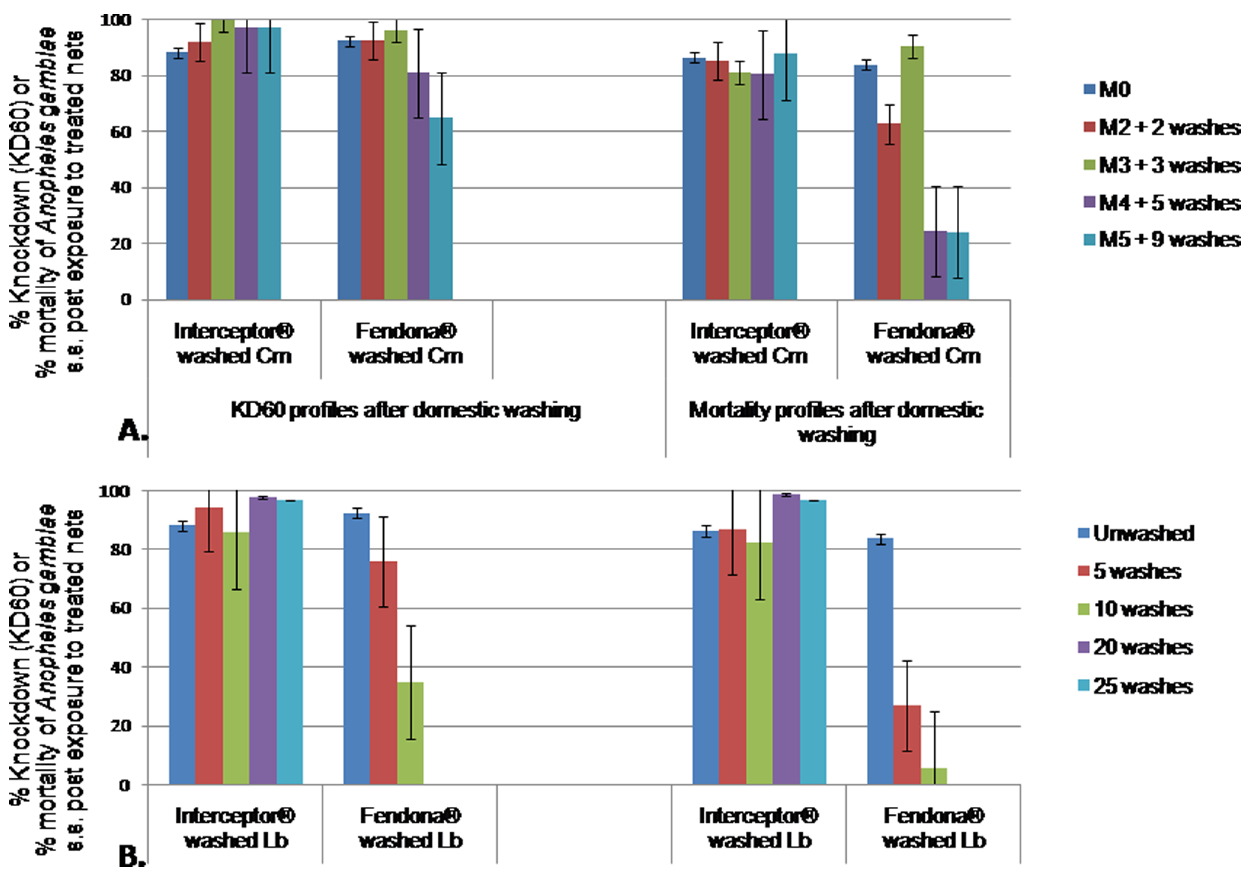
Figure 3. Knockdown and mortality rates of susceptible Anophelesgambiae s.s. post contact with Alpha-cypermethrin long lasting washed nets. A: Nets used and washed in community; B: Nets washed in laboratory conditions, M0, M1, M2, M3, M4, M5: month 0, month 1, month 2, month 3, month 4, month 5; KD60: knockdown rate of mosquitoes 60 minutes post contact to treated material; washed CM: nets washed in the community; washed Lb: nets washed in the laboratory. Interceptor Nets remained highly effective after washing up to 25 times in the laboratory or 9 times at community level, although a slight but significant decrease of KD60 and mortality rates was seen after each washing cycle (p , 0.05). With Fendona, the KD60 and mortality rates remained high until 3washes either in the lab or at community level. No significant difference of wash resistance was seen between laboratory and community washing procedures (p , 0.05).